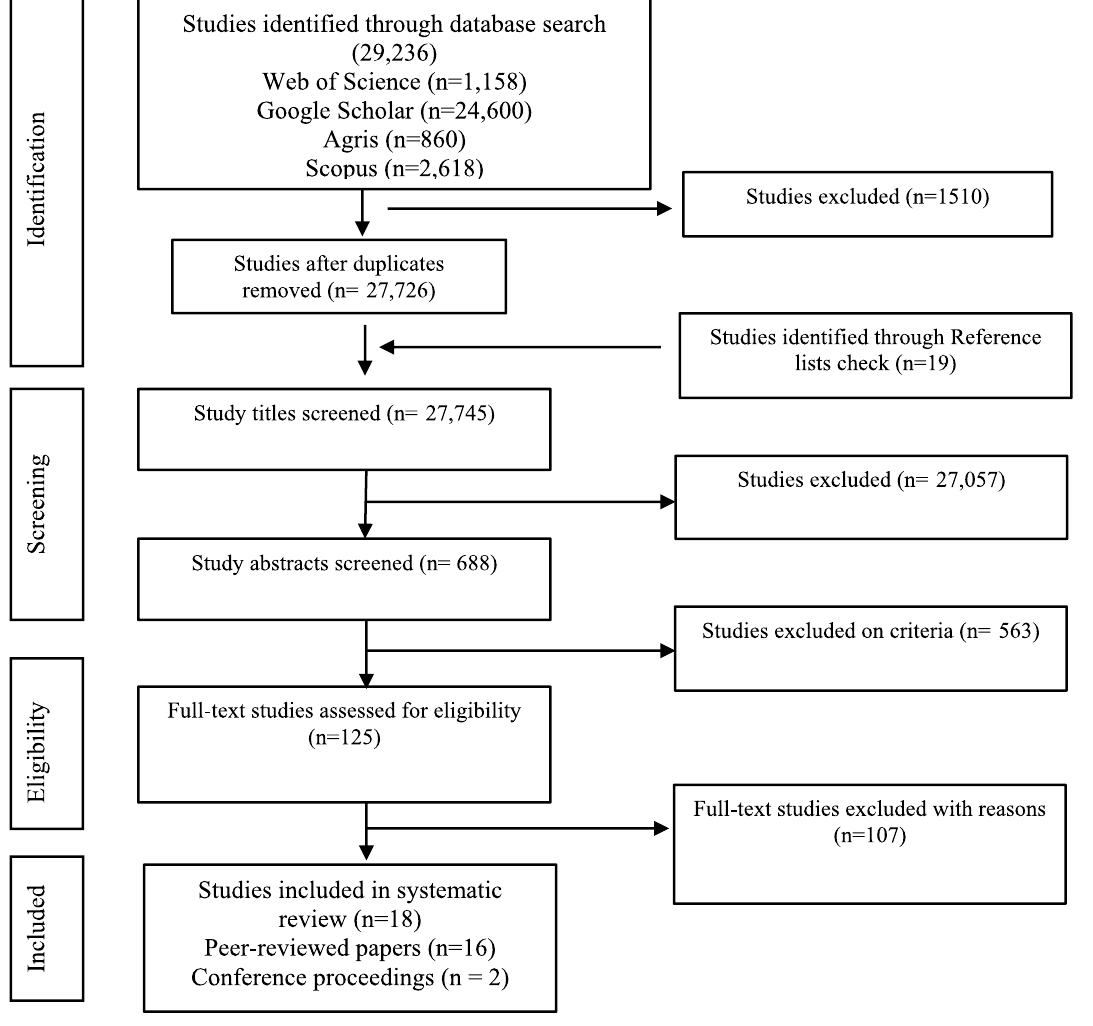
Fig. 1 Flow of information through the different